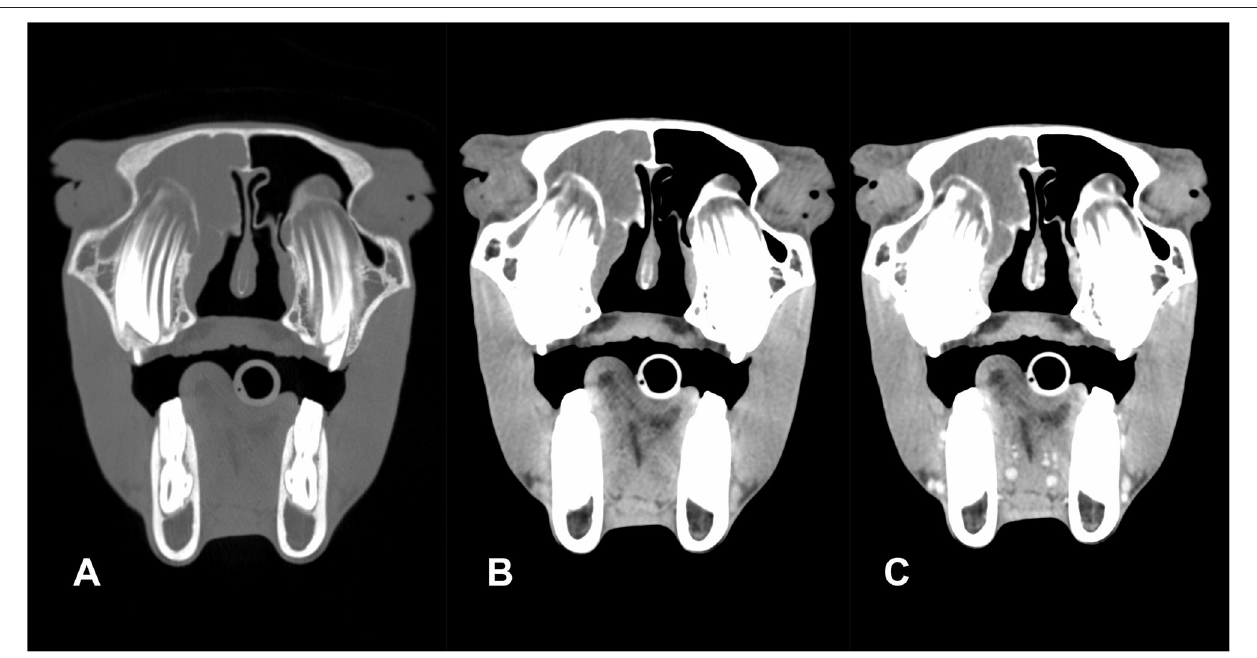
FIGURE 3 | Transverse pre-contrast CT images of an American miniature horse with unilateral disease (case 5) processed with bone (A) and soft tissue (B) filters and post-contrast CT image (C) (left in the image is right of the patient): the right sinus compartments were diffusely filled with fluid attenuating material (HU: 20). There is subtle leftward deviation of the nasal septum. There is mild contrast enhancement of the mucosal lining of the concho-frontal sinus but no enhancement of the sinus